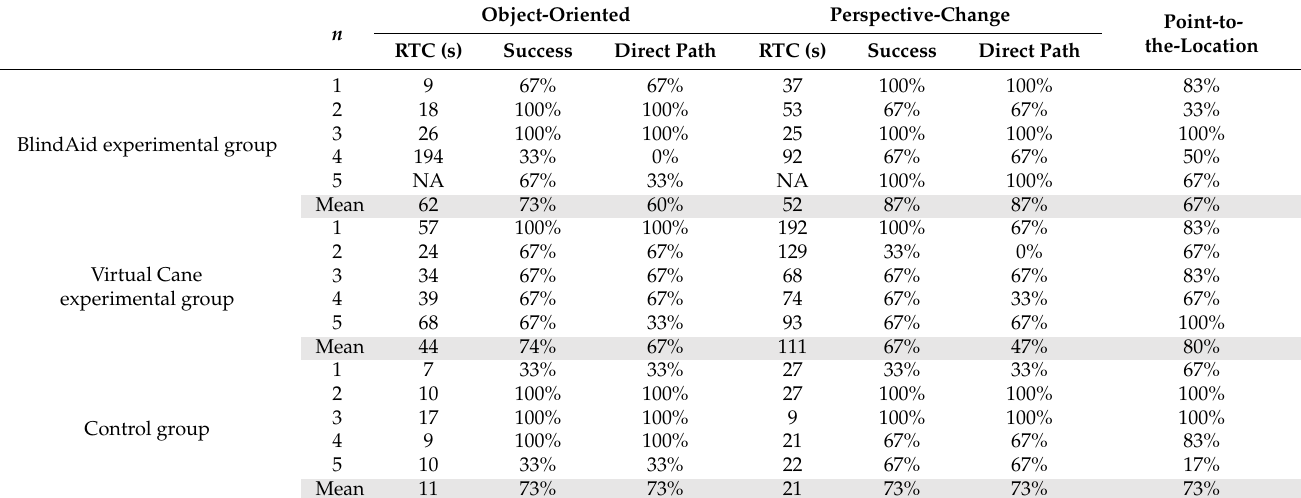
Table 6. Success in orientation tasks in simple space.